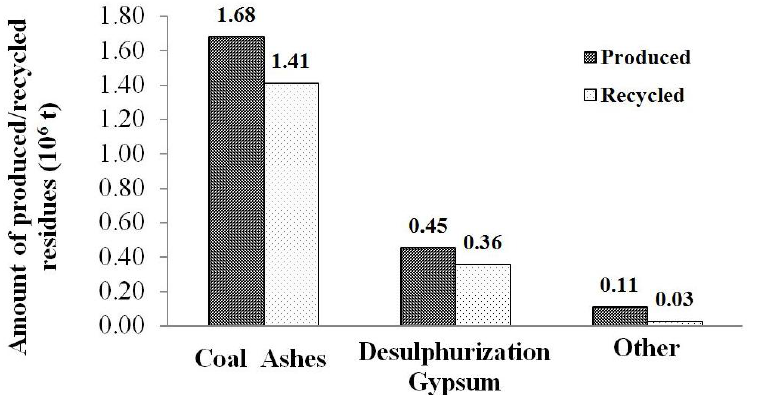
Figure 2. Coal combustion residues amounts production and recycling in Italy in 2012 (adapted with permission from ENEL Environmental Report, 2012 [30]. Copyright by the National Agency for Electric Energy,